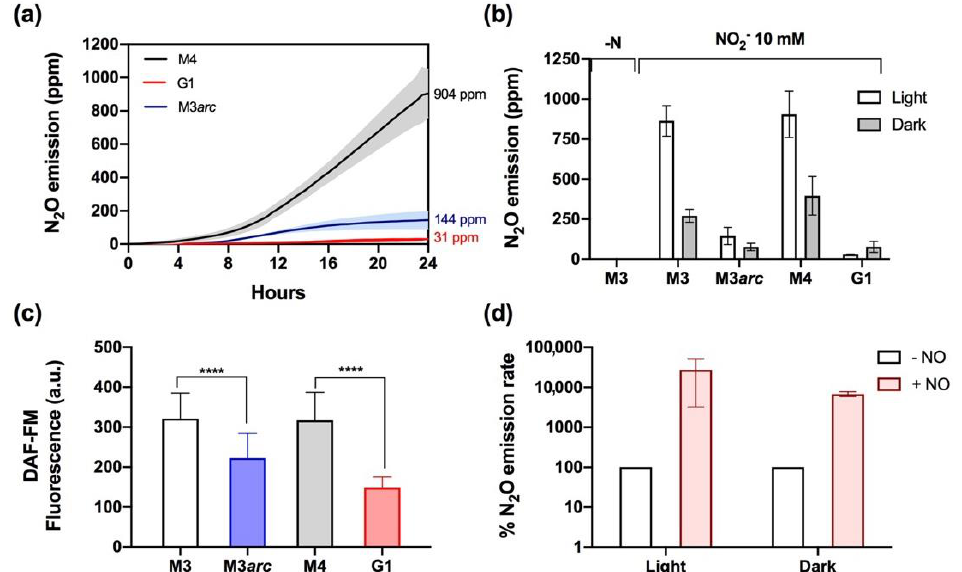
Figure 3. N 2 O emission by the nii1 mutants mainly depends on the functionality of the NR – ARC complex to reduce NO 2 − to NO. ( a ) N 2 O emissions by M3, G1, and M3 arc strains in media contain- ing 10 mM NO 2 − in the light. ( b ) Effect of light and dark on total N 2 O emission in the nii1 mutants in the presence of 10 mM NO 2 − after 24 h. ( c ) DAF-FM fluorescence in the nii1 mutants after 24 h incubation in 10 mM NO 2 − in the light. ( d ) N 2 O emission rates after adding 40 µ M DEA-NONOate to G1 cultures in light and dark conditions. The initial rates (100%) correspond to 0.66 ppm/h (light) and 4.42 ppm/h (dark). Each data line in ( a ) represents an average of three biological replicates, and the colored area corresponds to ±SD. Error bars represent ±SD, n ≥ 3. Student’s t test was performed. **** p ≤ 0.0001.